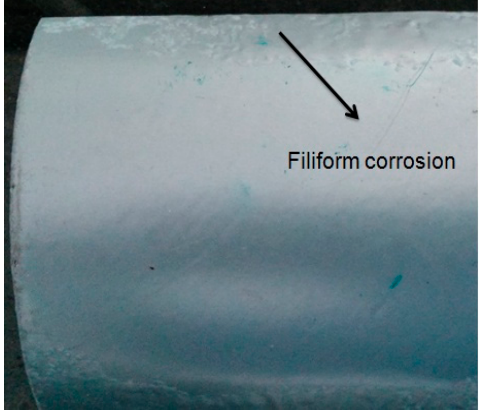
Figure 11. 2-coat polyester without primer.